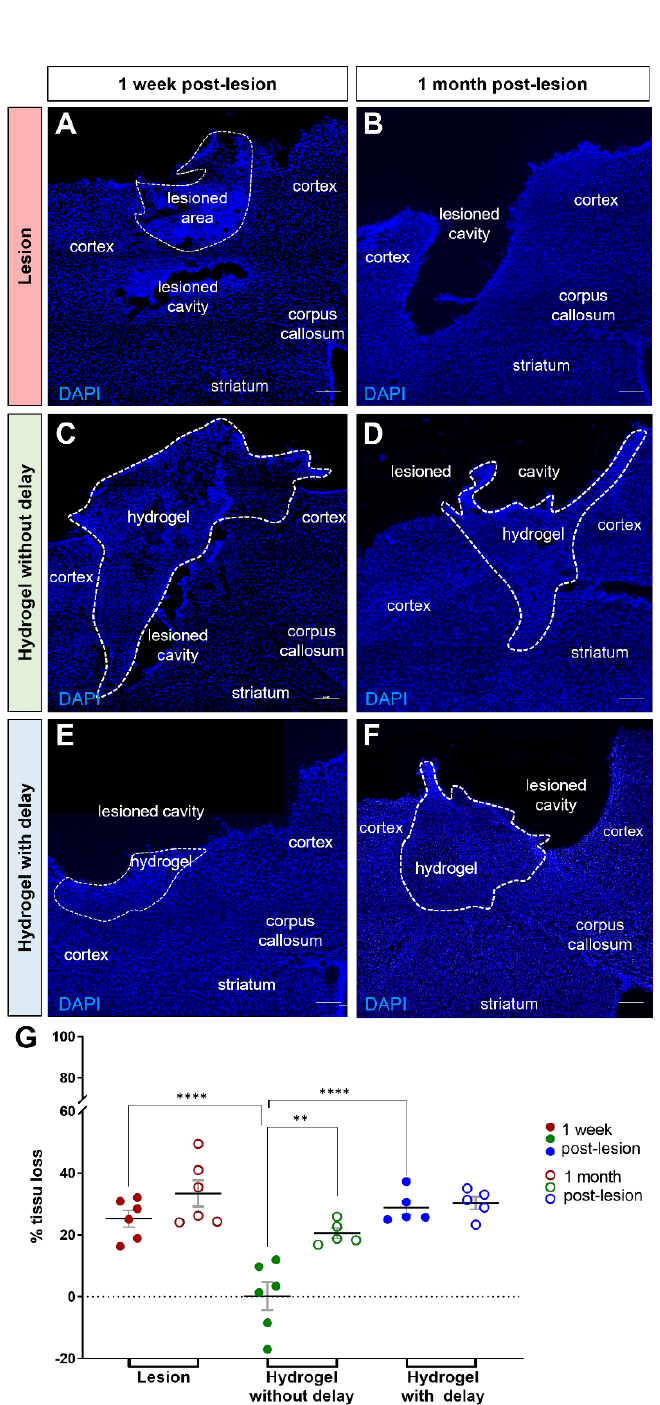
Figure 2. Cortical tissue loss one week and one month after the lesion. ( A – F ) Representative images of cells labeled with DAPI (blue) in lesioned ( A , B ) or implanted mice without delay ( C , D ) or with delay ( E , F ). Dashed lines indicate hydrogel localization. Scale bar: 200 µm. ( G ) Quantitative analysis of the cortical tissue loss over time in lesioned (red) or implanted mice without delay (green) or with delay (blue). Two-way ANOVA ** p < 0.01 **** p < 0.0001.